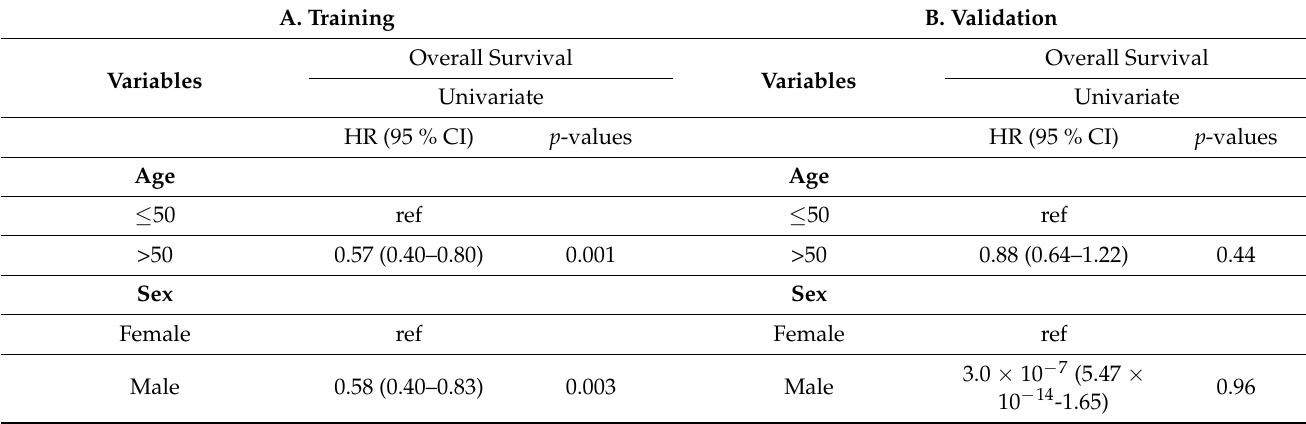
Table 1. Univariate analysis of overall survival of liver disease patients according to possible prognostic variables Analysis of (A) the training and (B) of the validation set. Abbreviations: HR = hazard ratio; CI = confidence interval; ref =